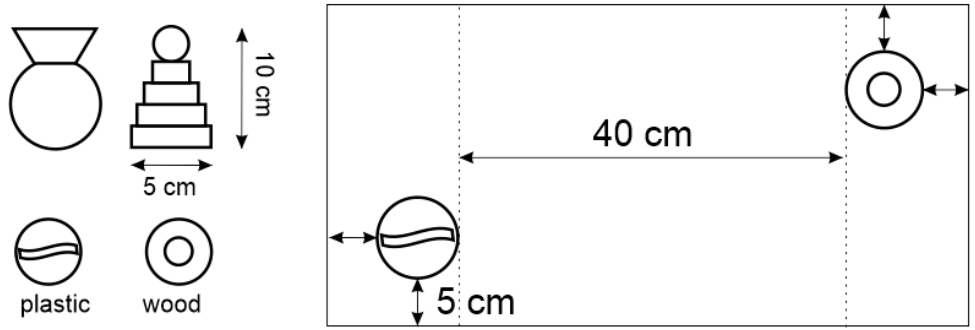
Figure 13. The objects for the novel object recognition test and their mutual arrangement in Plexiglas box. Plexiglas